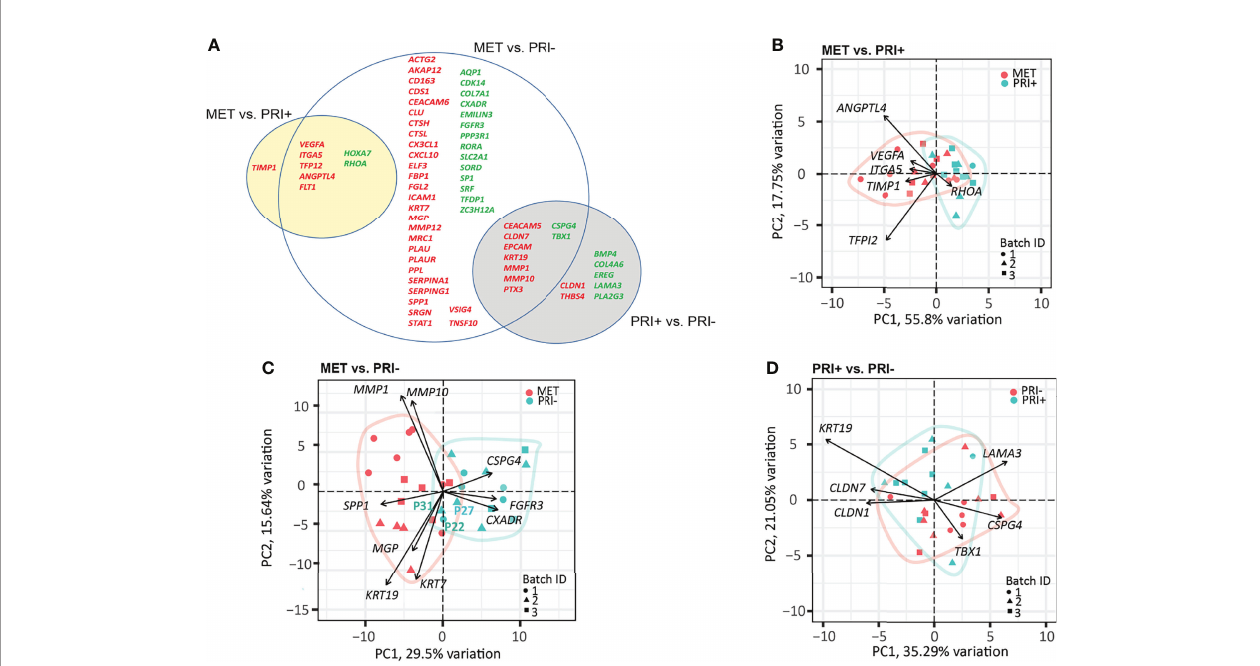
FIGURE 3 | Cancer progression gene panel differential expression analysis between tumor cohorts. (A) Venn diagram depicting DEGs with log2 fold change ≥ 1 or ≤ -1 between MET vs. PRI+ and MET vs. PRI- (adjusted p -values <0.05), and PRI+ vs. PRI- ( p -values <0.01). Upregulated (red) and downregulated (green) DEGs for each pairwise comparison are indicated. The overlap between the circles show DEGs genes that occur in more than one comparison. (B – D) PCA loading plots based on signi fi cant DEGs between (B) MET and PRI+ (8), (C) MET and PRI- (54), and (D) PRI+ and PRI (16). Each symbol corresponds to one sample. Ellipses represent the region where the majority of samples are expected to fall. Non-overlapping ellipses imply that gene expression pro fi les cluster groups apart based on their distinct principal component scores. Batch ID symbols indicate samples analyzed in different NanoString runs and show lack of batch